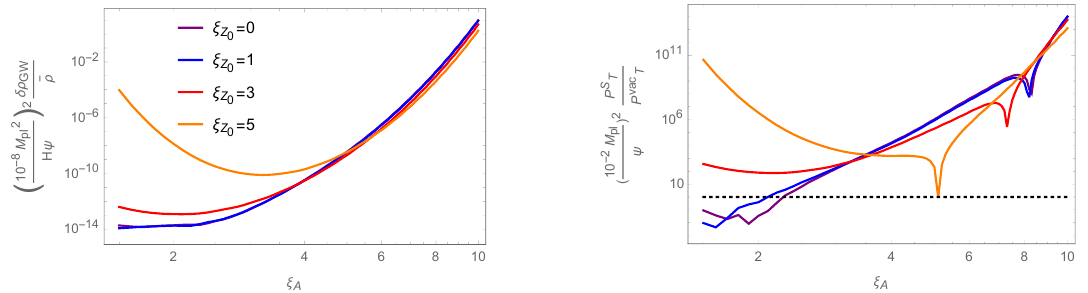
Figure 8 . The prefactors jG + j 2 (left) and jA + j 2 (right) as functions of (cid:24) A and (cid:24) Z dashed line shows unity.